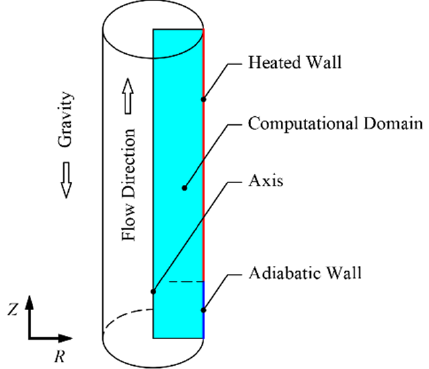
Figure 3. Schematic diagram of the vertical pipe.